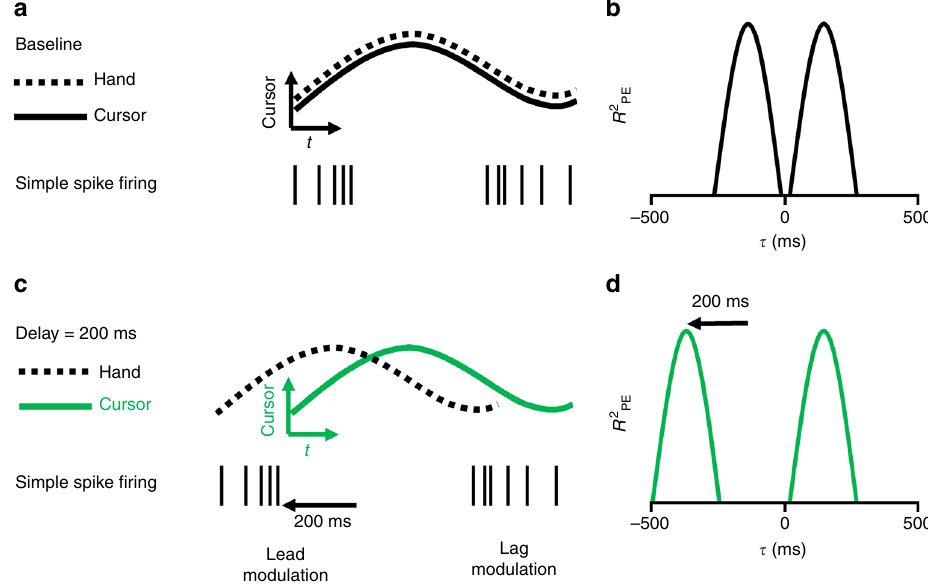
Fig. 2 Rationale for the delay condition experiment. a In the baseline condition the cursor (continuous trace) and hand (dashed trace) movements are indistinguishable. Simple spike fi ring both leads (left spike train) and lags (right spike train) the cursor movement. b Temporal R 2 pro fi le of the SS fi ring with the position error includes a leading ( τ < 0) and lagging ( τ > 0) peak. c In the delay condition, hand movement occurs before the cursor movement by the delay imposed. Based on the forward model hypothesis, the lead SS modulation is time-locked to hand movement and will shift earlier relative to cursor movement. The lag modulation should be time-locked to the cursor movement. d In the delay condition, the lead R 2 peak should shift earlier and the lag R